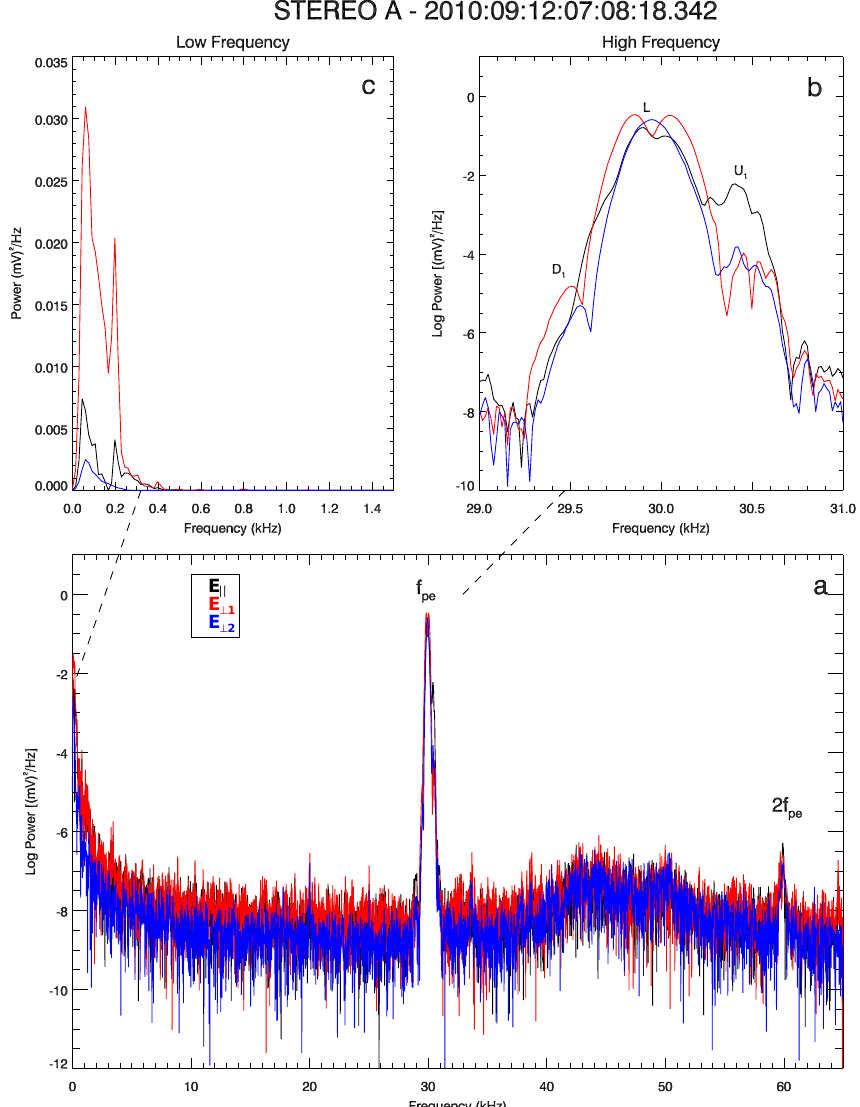
Fig. 4. (a) The superposition of the complete spectra of the parallel and perpendicular components of the wave packet; (b) the narrow spec- trum around f ∼ f pe ∼ 30kHz, where L, D, and U correspond to the beam-excited Langmuir wave, down-shifted sideband at ∼ 29 . 5kHz, and up-shifted sideband at ∼ 30 . 5kHz, respectively; and (c) the low-frequency spectrum: the enhancement below 400Hz corresponds to ion sound